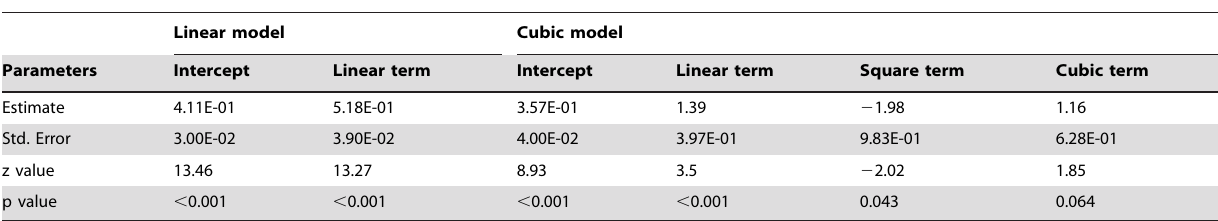
Table 3. Parameters for the linear and cubic